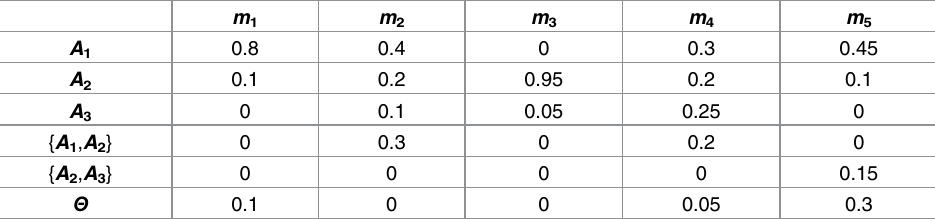
Table 1. BBAs of five evidences.